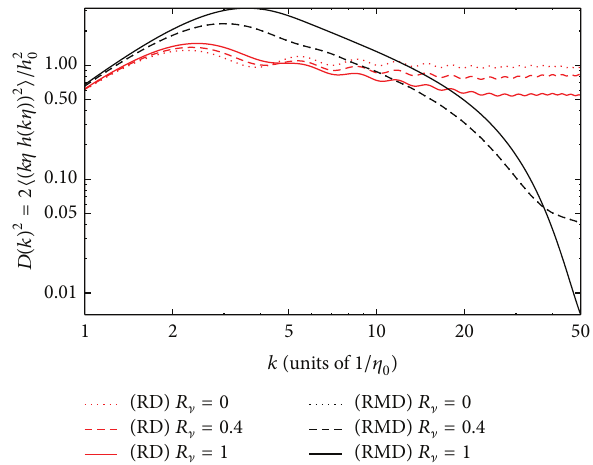
Figure 2: Time-averaged values of 2⟨(𝑘𝜂) 2 |ℎ 𝑖𝑗 (𝑘𝜂)| 2 ⟩ as function of 𝑘[ Mpc −1 ] for RD (red lines) and RMD (black lines) background cosmic inventories. Results are for vanishing anisotropic stress, with = 0 (dotted lines), for 𝑅 = 0.4(0.4052) (dashed lines) and for 𝑅 ] ] = 1 (solid lines). Notice the fake resonance effect for modes with 𝑅 ] 𝑘𝜂 ≳ 1 followed by the neutrinos damping effect which is more relevant for scales deep inside the